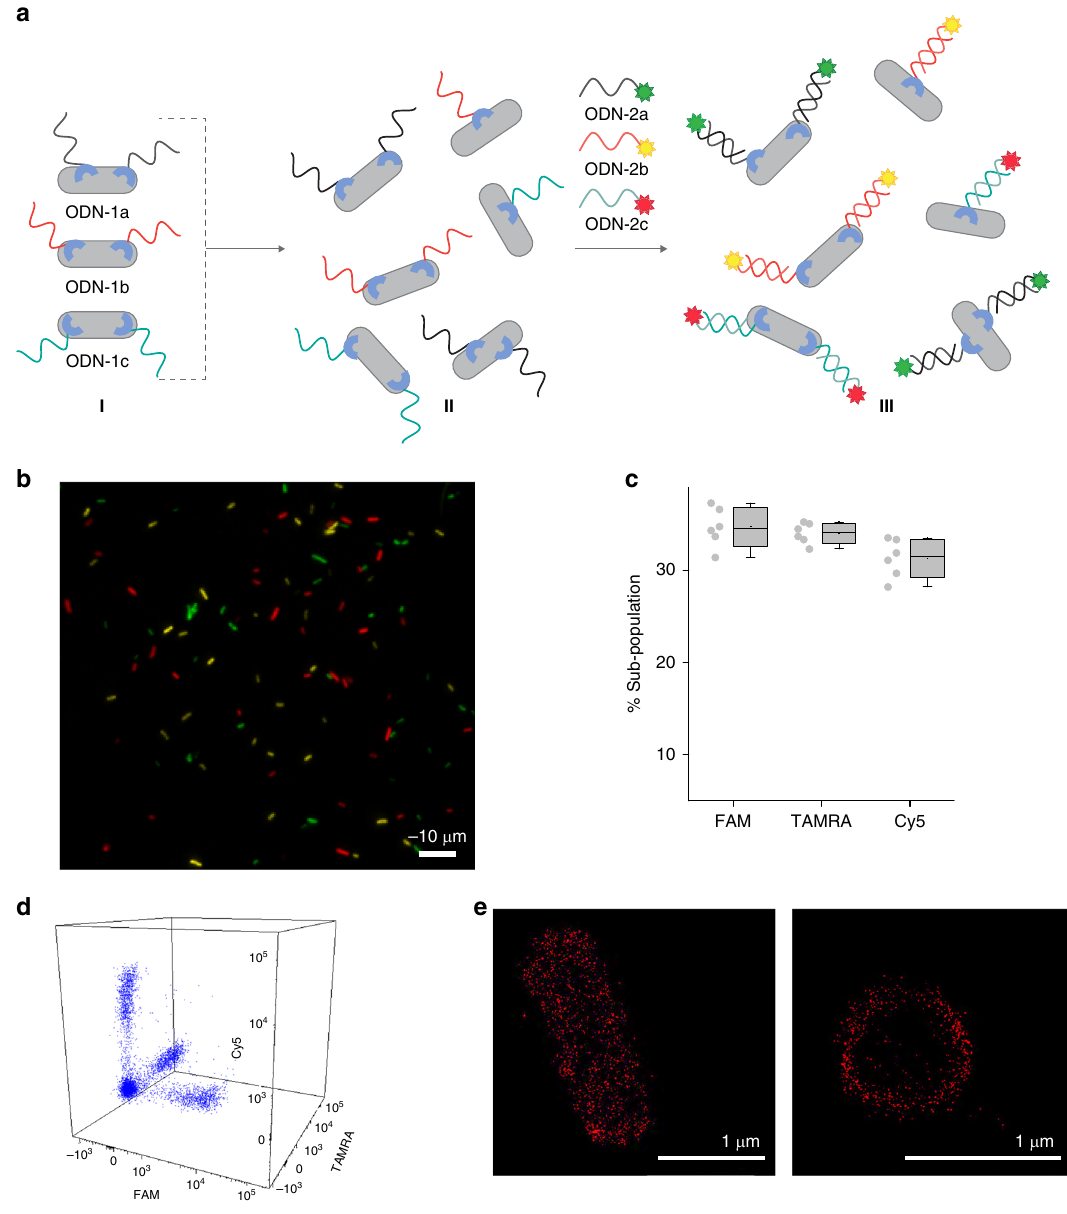
Fig. 6 Controlling bacterial cell surface luminescence. a Schematic illustration of the way sub-populations of His-tagged bacteria bearing arti fi cial receptors can be prepared (I), mixed (I → II), and selectively modi fi ed in the mixture (II → III) using ODN-2s appended with FAM, TAMRA, and Cy5. Complementary sequences are denoted in similar colors. b Fluorescence image of the labeled mixed population. The image corresponds to state III in the scheme. The bacteria were imaged using 488, 561, and 647 nm excitation lasers. c Percentage of each sub-population in the mixture. The error bars represent the s.d. of six frames. d Flow cytometry analysis of the mixed population. e STORM images of His-tagged bacteria decorated with the ODN-1: Cy5-ODN-2 duplex. Left: whole bacteria. Right: transverse cut viewed from the plane of the cell axis. Source data are available in the Source Data fi